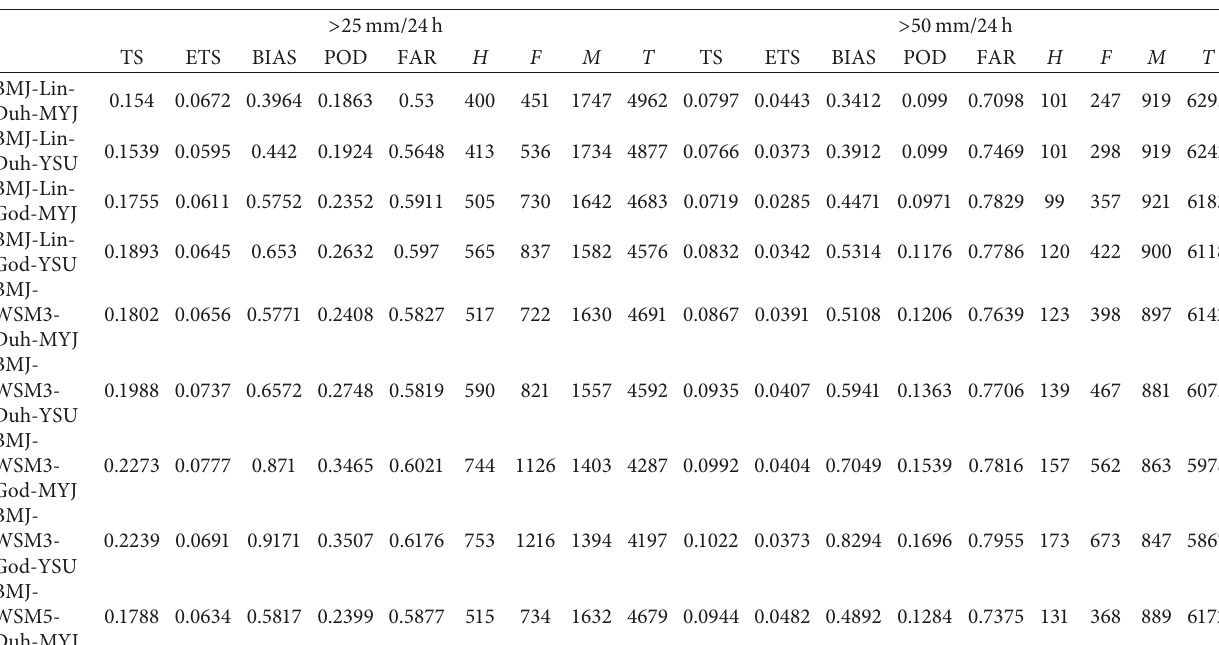
Table 6: Skill scores (TS, ETS, BIAS, POD, and FAR) and hit rates H , false alarm rates F , missed rates M , and total corrected rates T at the 72h forecast range for thresholds > 25mm/24 h and > 50mm/24 h, for the period 2012–2016. The number of samples is